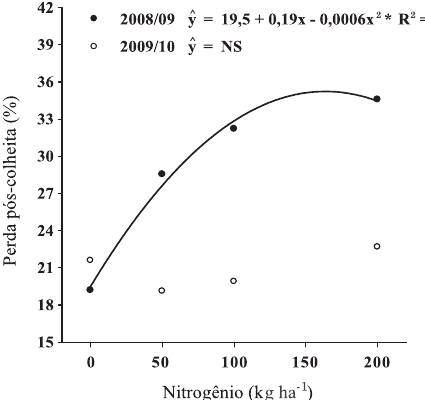
Figura 2. número de folhas (a), altura de plantas (b) e número de folhas eretas (c) de cebola em função da adição de doses crescentes de nitrogênio ao solo, em duas safras. *: significativo (p ≤ 0,05).